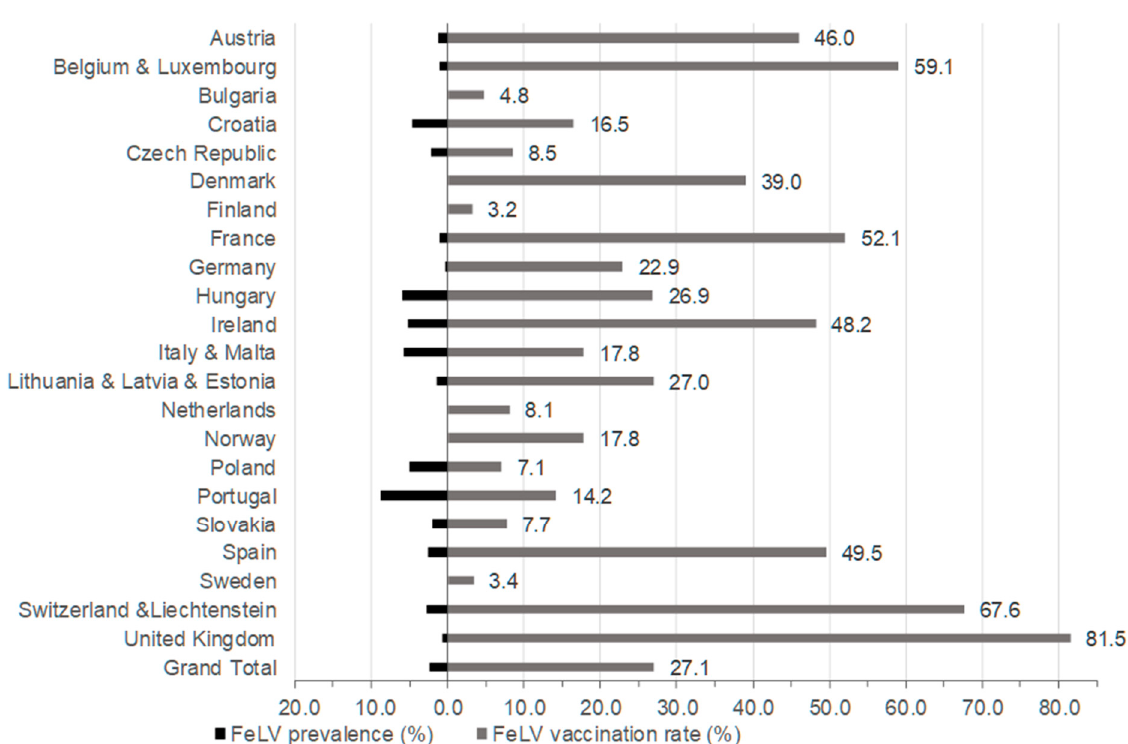
Figure 3. FeLV prevalence (on the left) and FeLV vaccination rates (on the right) in the different countries/country groups. In the FeLV vaccination rates, cats with unknown vaccination status were not included (~10% of the cats).